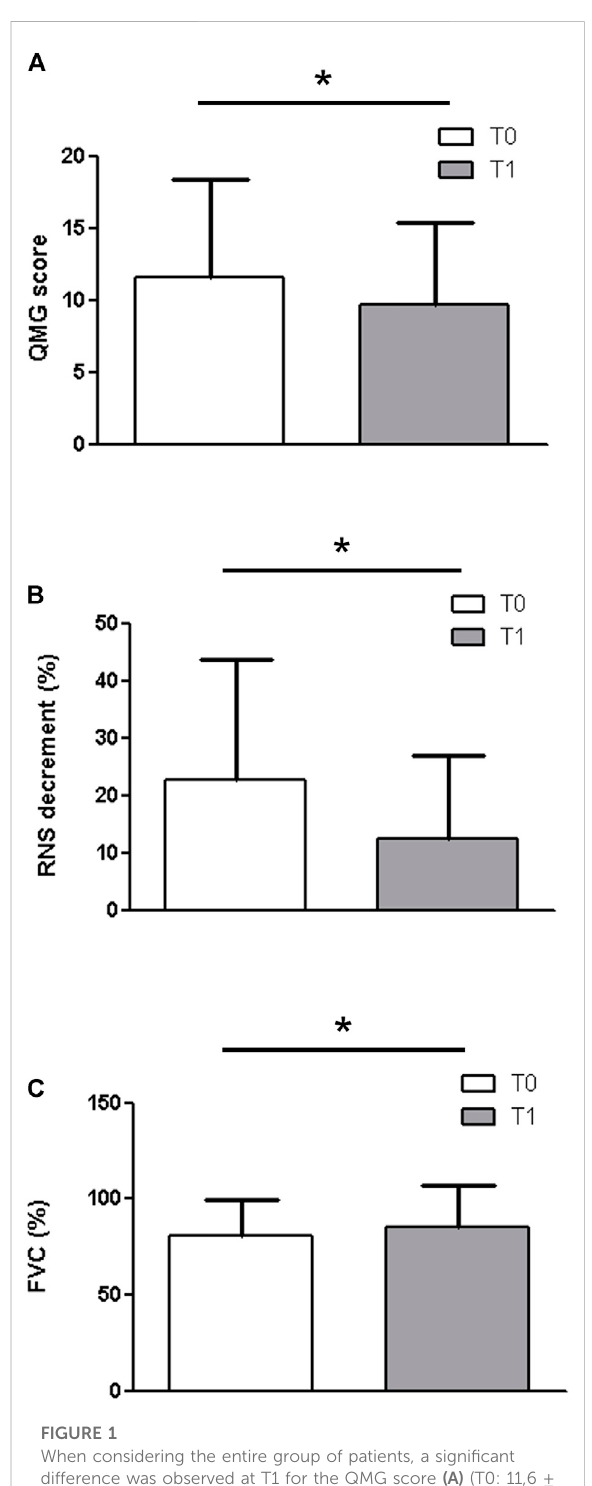
FIGURE 1 When considering the entire group of patients, a signi fi cant difference was observed at T1 for the QMG score (A) (T0: 11,6 ± 6.80; T1: 9.67 ± 5.7 p = 0.0251), the RNS decrement (B) (T0: 22.73 ±21.06;T1:12.53±14.28. p =0.0251)andfortheFVC (C) (T0: 80.53 ± 18.75; T1: 85.47 ± 21.44. p = 0.